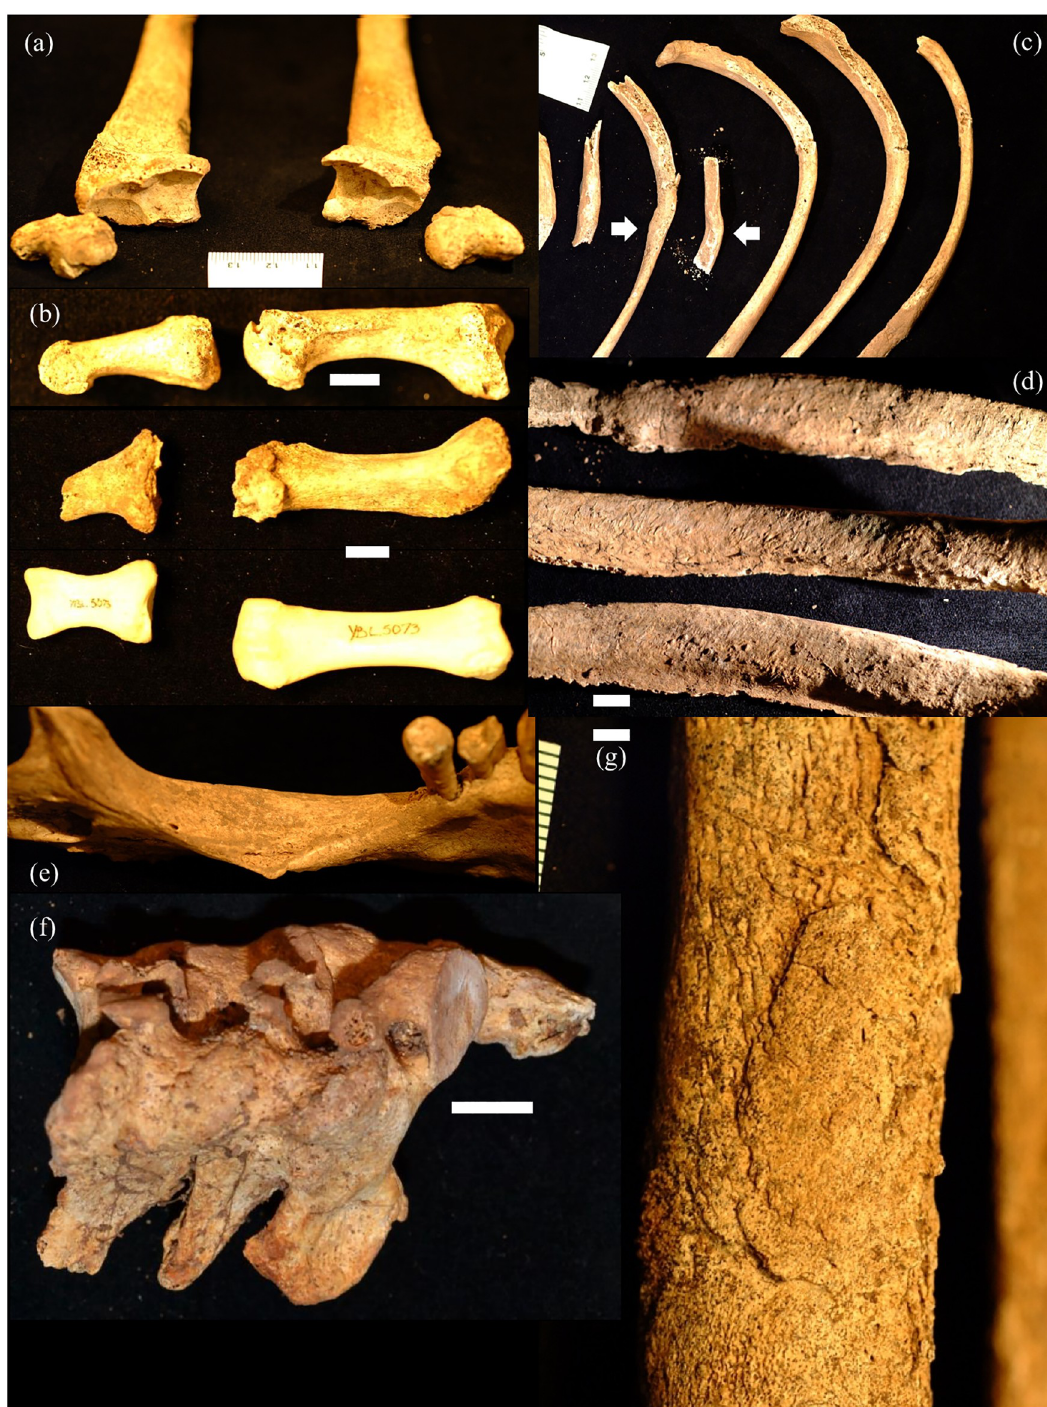
Fig 15. YNH4 B3 pathology markers. a) bilateral distal radii eburnation, b) gout indicators in the pedal and manual rays compared to normal ray (bottom), c) callous bone formation at rib fracture (arrow), d) remodeling of rib surfaces, e) left mandibular corpus antemortem fracture, f) fused C2-4 vertebrae, g) = distal tibia remodeling. Bar scale = 5mm.